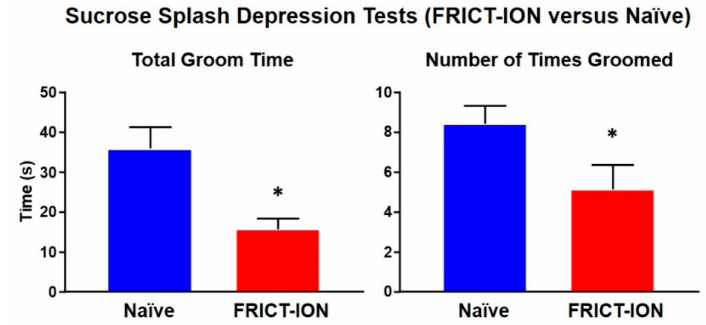
Figure 1. Depression assessed by spraying 10% sucrose on the rump of mice results in grooming behaviors in naïve male mice but significantly less grooming in mice with neuropathic pain induced by FRICT-ION model at 6 weeks. The asterisk indicates p < 0.05 compared to naïve ( n =